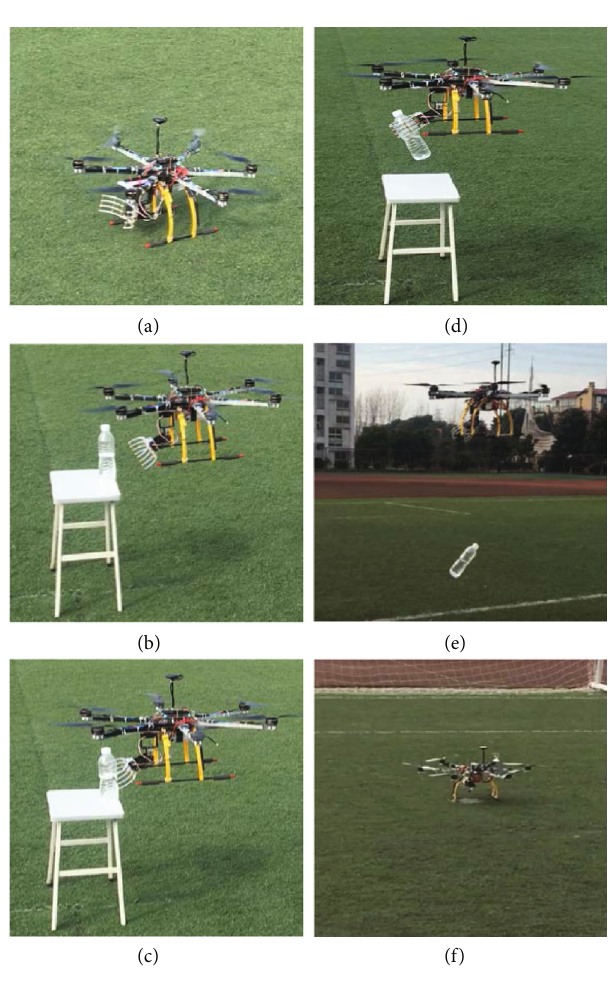
Figure 12: Snapshots of the objective operation.